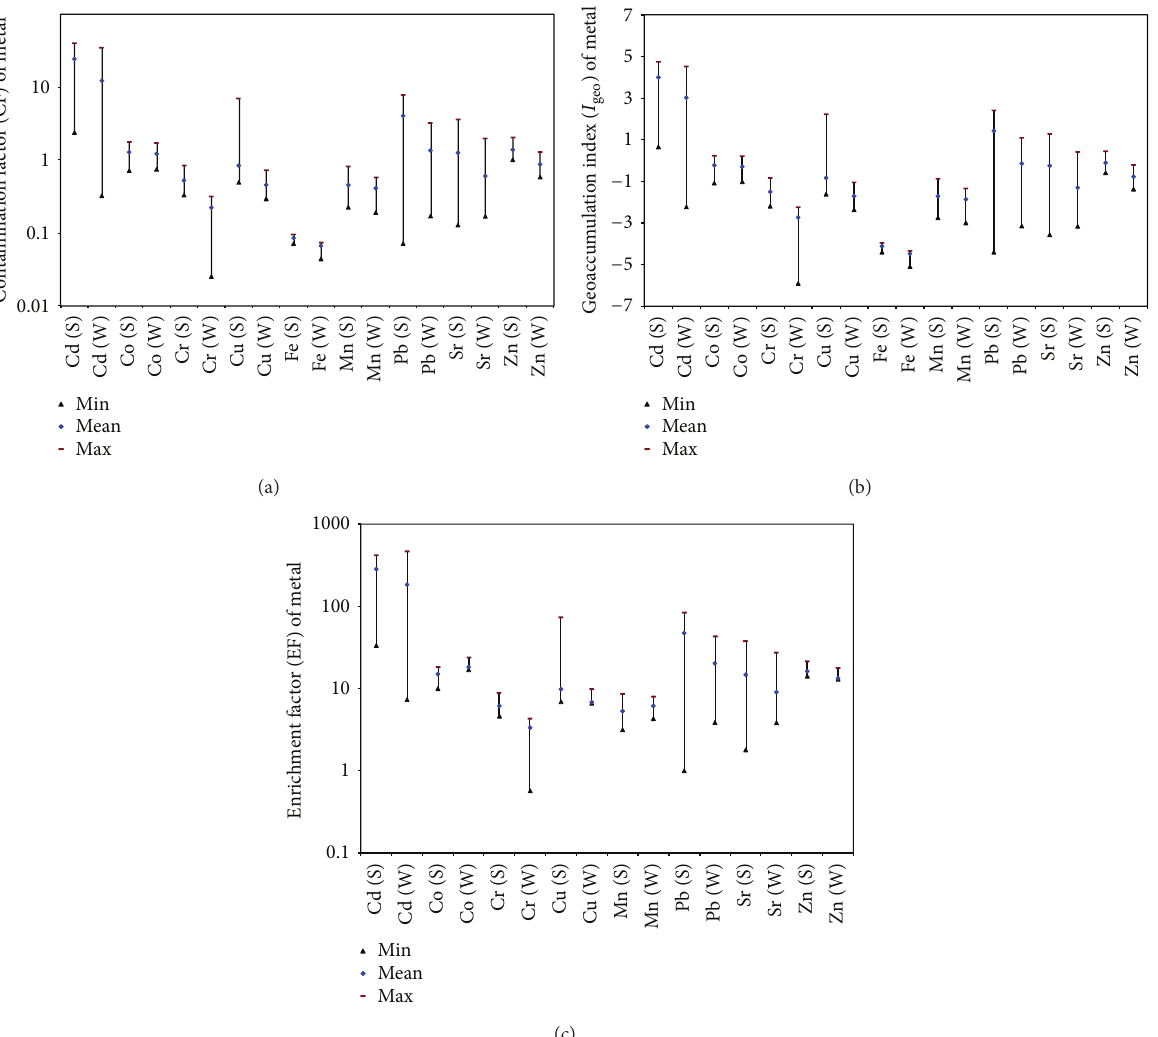
), and enrichment factor (EF) in soil in summer (S) and geo